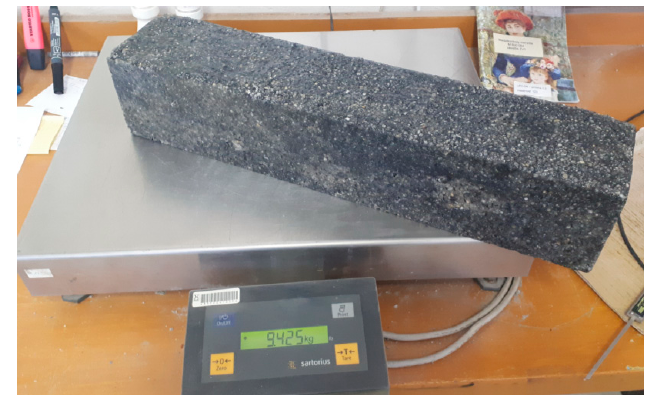
Figure 6. Weighing the test sample.